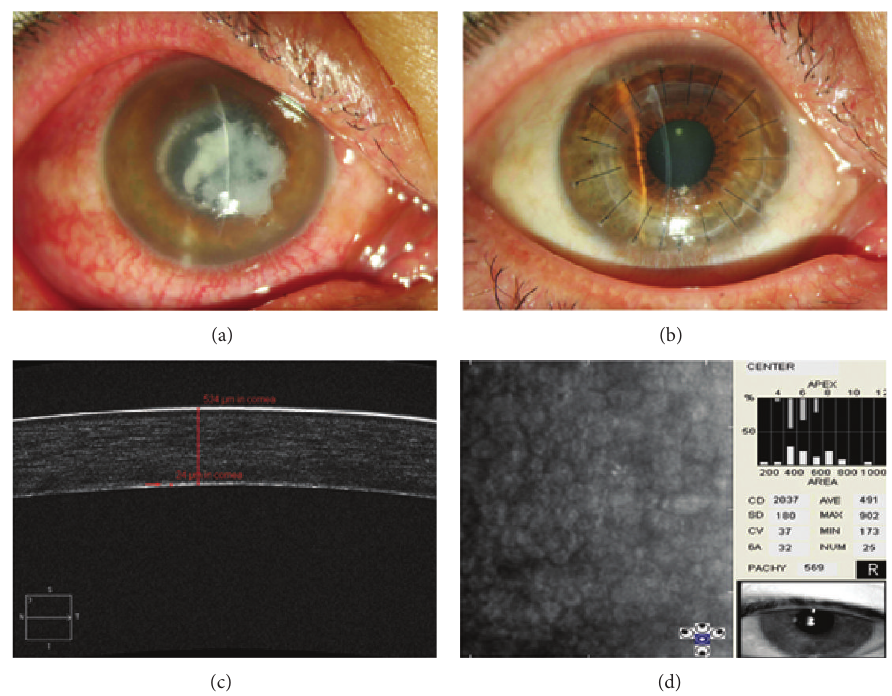
Figure 3: Slit-lamp photographs of fungal keratitis before deep anterior lamellar keratoplasty (CDVA = 0.02; (a)) and after surgery (CDVA = 0.8; (b)). AS-OCT shows that the recipient bed thickness is 24 𝜇 m, the graft and recipient match well, and the graft-host interface (red arrow) can hardly be seen (c). The endothelial cell density is 2037 cells/mm 2 by specular microscopic examination